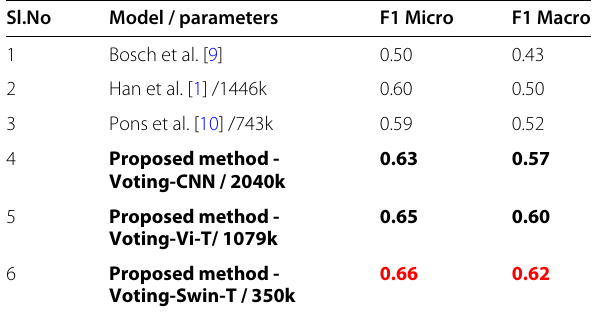
Table 7 Performance comparison on IRMAS dataset. The best result in the proposed scheme is highlighted in